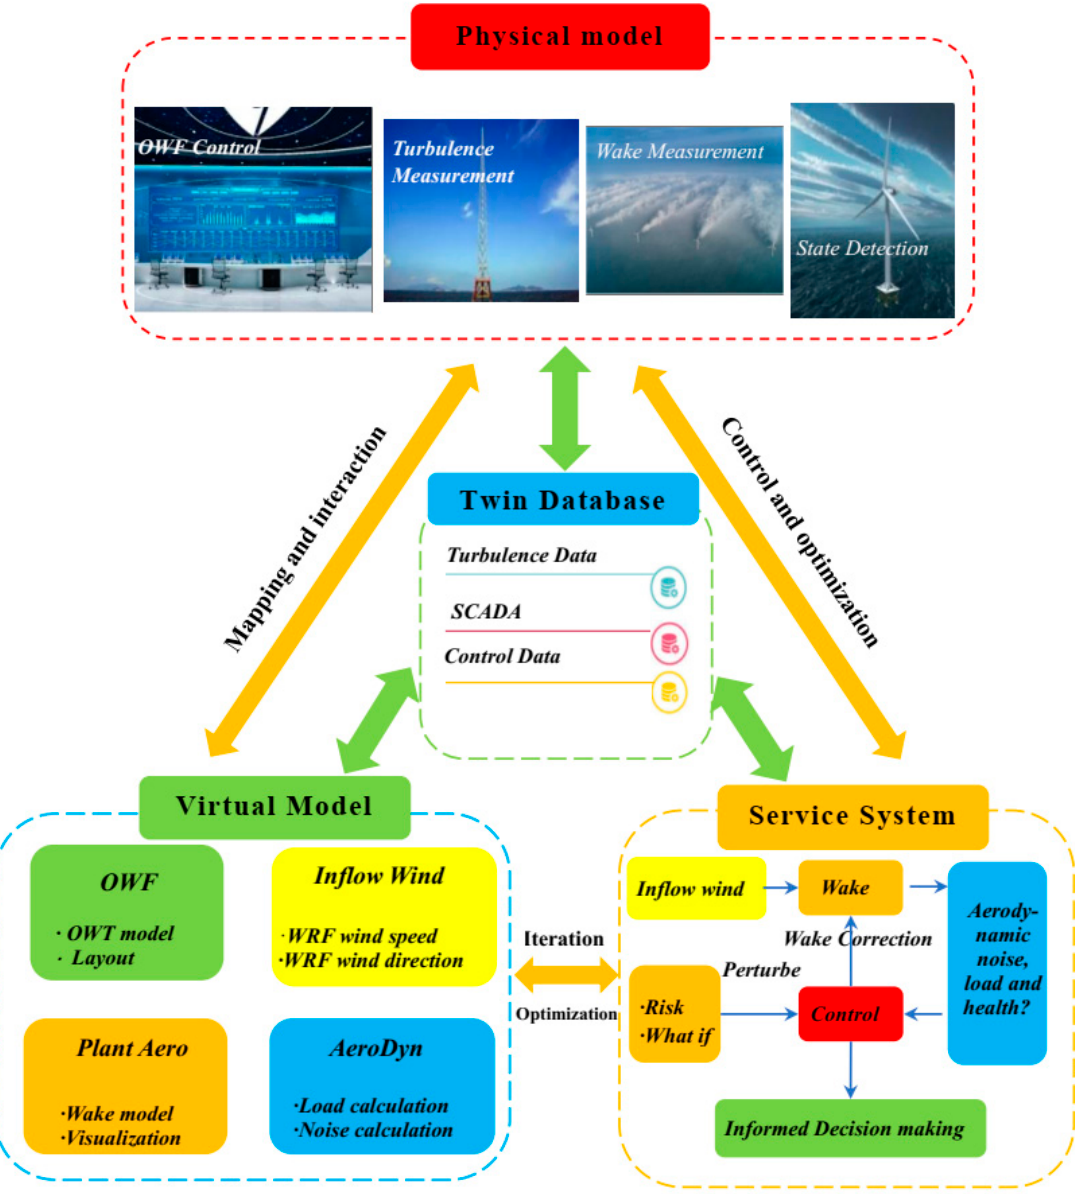
Figure 7. Schematic diagram of the digital twin of the OWF dynamic wake management.